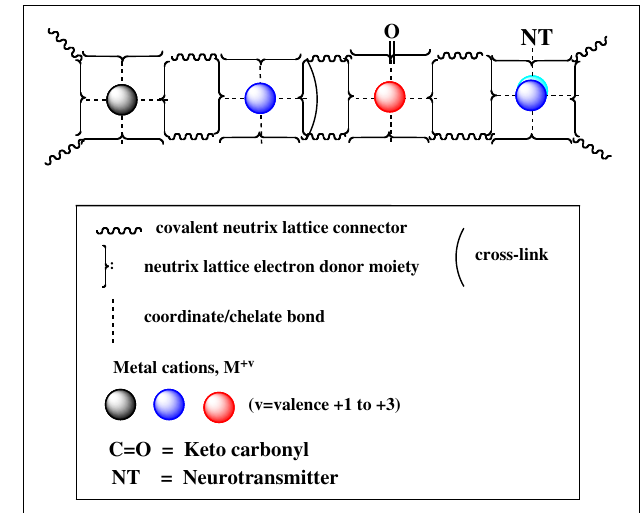
FIGURE 8 | A set of cuinfo , tagged with keto group and a generic neurotransmitter